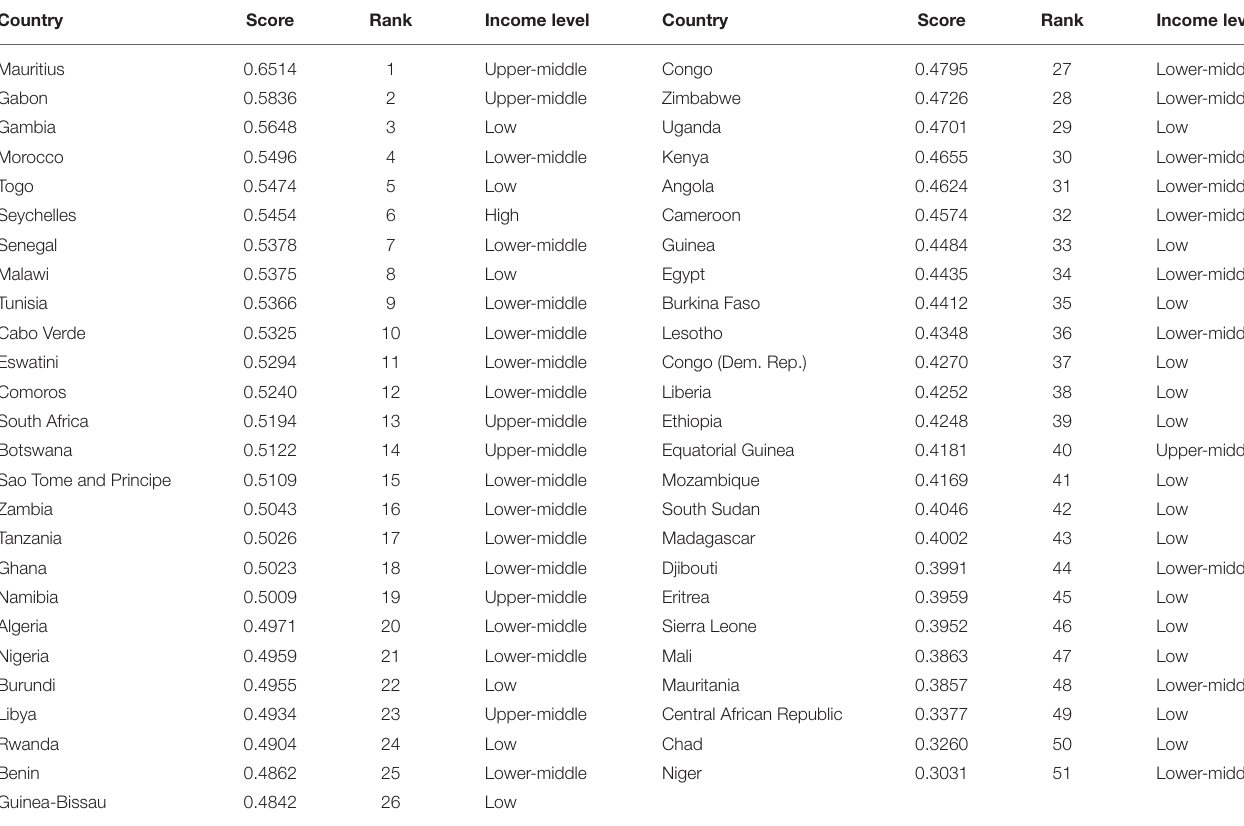
TABLE 4 | The score of SD in public life, education, and welfare in Africa.